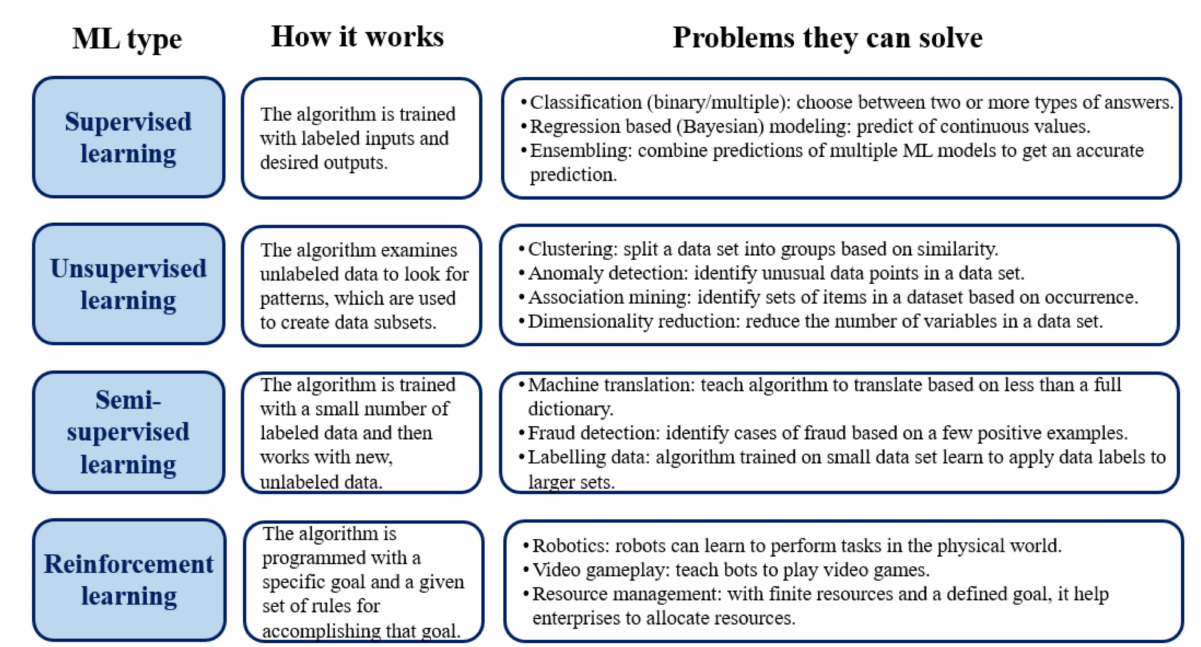
Figure 2. ML types: how they work and what problems can they solve (source: adapted from [44,45]). In supervised learning, algorithms are supplied with labeled data to be used in